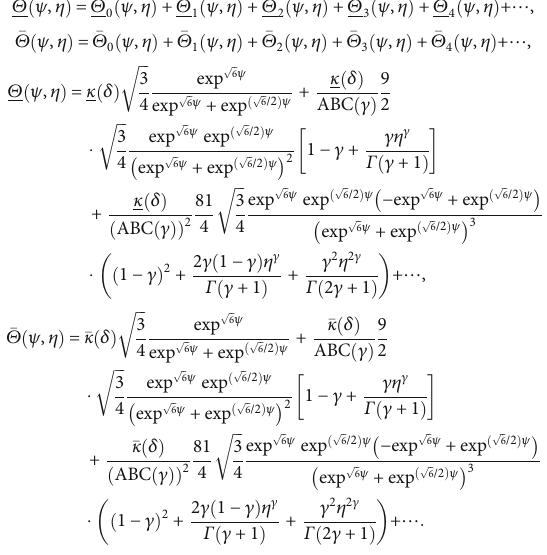
Figure 14: The fi rst graph shows the fuzzy 3D upper and lower fi gure of the various fractional orders of γ